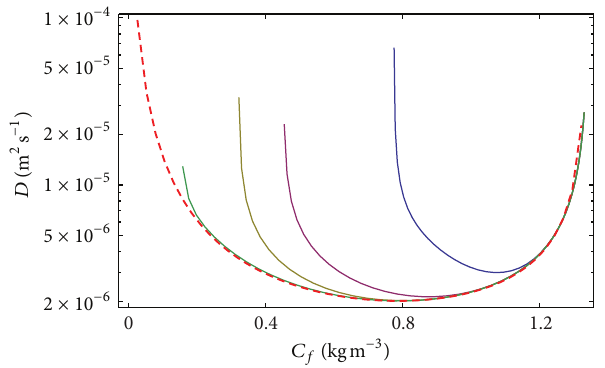
Figure 5: The concentration dependence of the chloride diffu- sion coefficient obtained numerically (the full lines) for 𝜂 𝜏 = , 1.5𝜂 , 2𝜂 , 5𝜂 𝜂 0 0 0 0 (from right to left). The thick dashed line indicates the case with an immediate binding of salt ( 𝜂 𝜏 → ∞